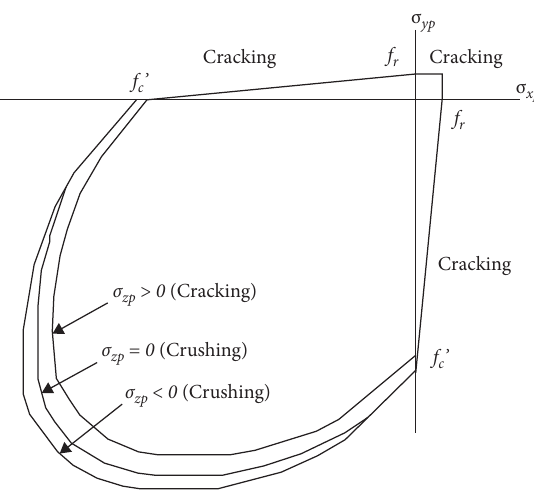
Figure 8: Failure Surface for concrete [31].